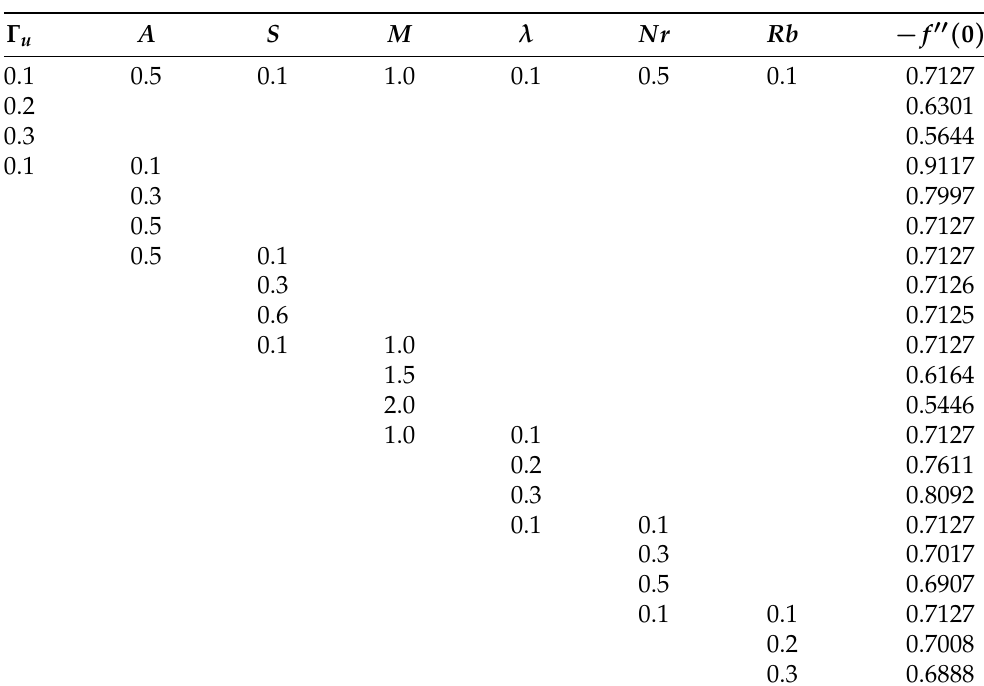
Figure 16. χ ( η ) fluctuate with Γ v and Γ n . Table 2. Results for − f (cid:48)(cid:48) ( 0 ) in x-direction.